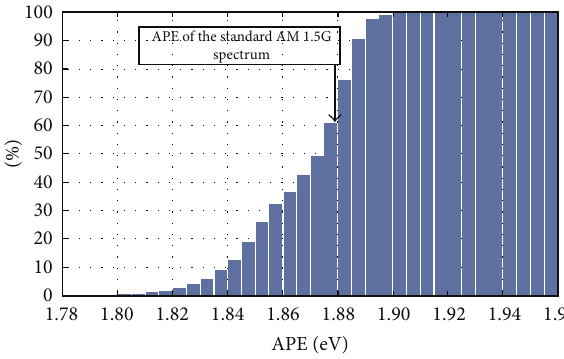
Figure 2: Percentage cumulative distribution of 𝐻 collected over the experimental campaign as a function of APE (class width =0.005 eV).